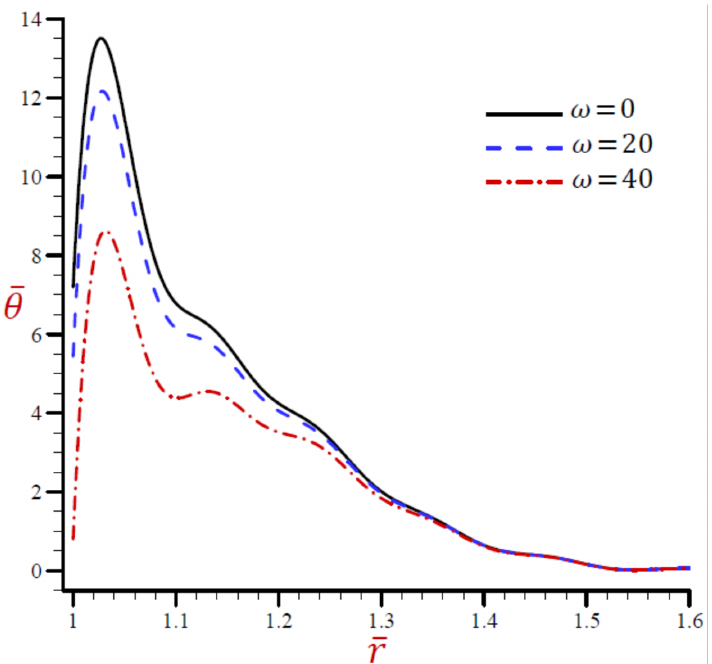
Figure 7. Effect of ω on temperature θ across the radial direction of the cylindrical cavity utilizing the RDPL